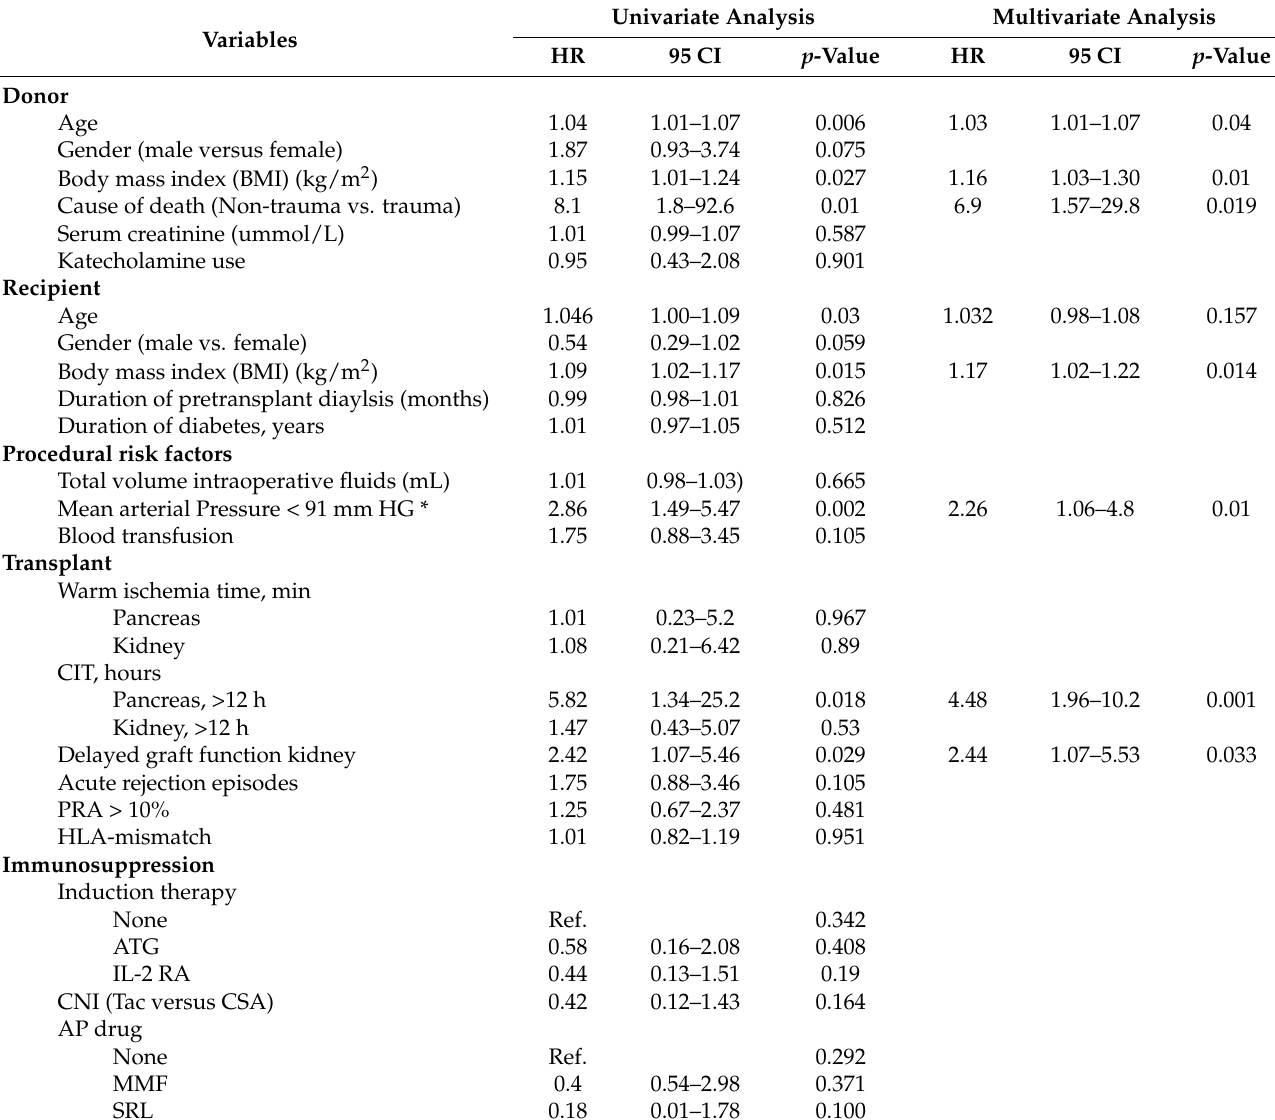
Table 5. Multivariate Cox regression analysis of predictors for pancreas allograft failure after simulta- neous pancreas–kidney